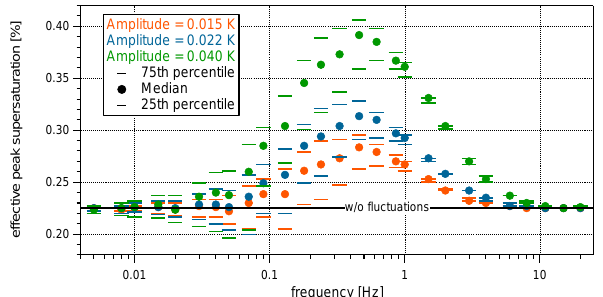
Figure 10. Dependency of the modelled effective peak supersatura- tions applying simulated small-scale fluctuations (SS fluc,sin cooling rate on the frequency. The applied small-scale fluctuation were obtained with a sinus function using three different amplitudes A = 0 . 015 (red), 0.022 (blue) and 0.04K (green), several frequen- cies in the range from 0.05 to 20Hz and phases from 0 to 360 ◦ with 18 ◦ steps. The circles indicate the median values, while the bars show the 25th and 75th